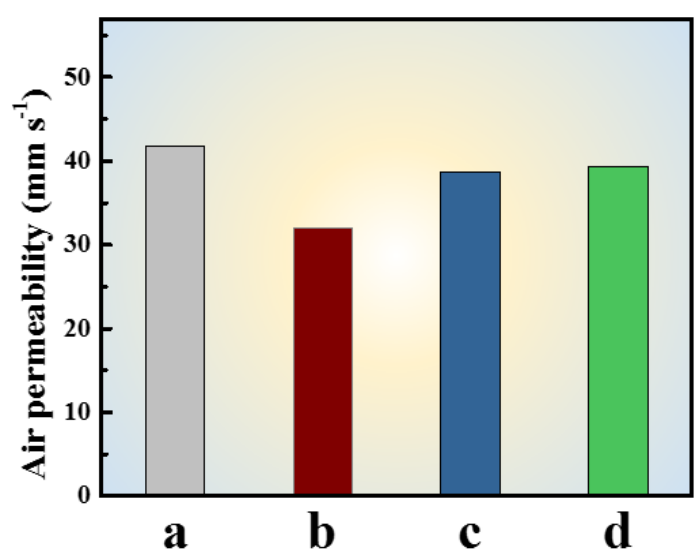
Figure 6. The air permeability of fabrics with different paste: ( a ) original fabric; ( b ) coated fabric without adding PVP; ( c ) coated fabric with adding 10% of PVPK30; ( d ) coated fabric with adding 20% of PVPK30.